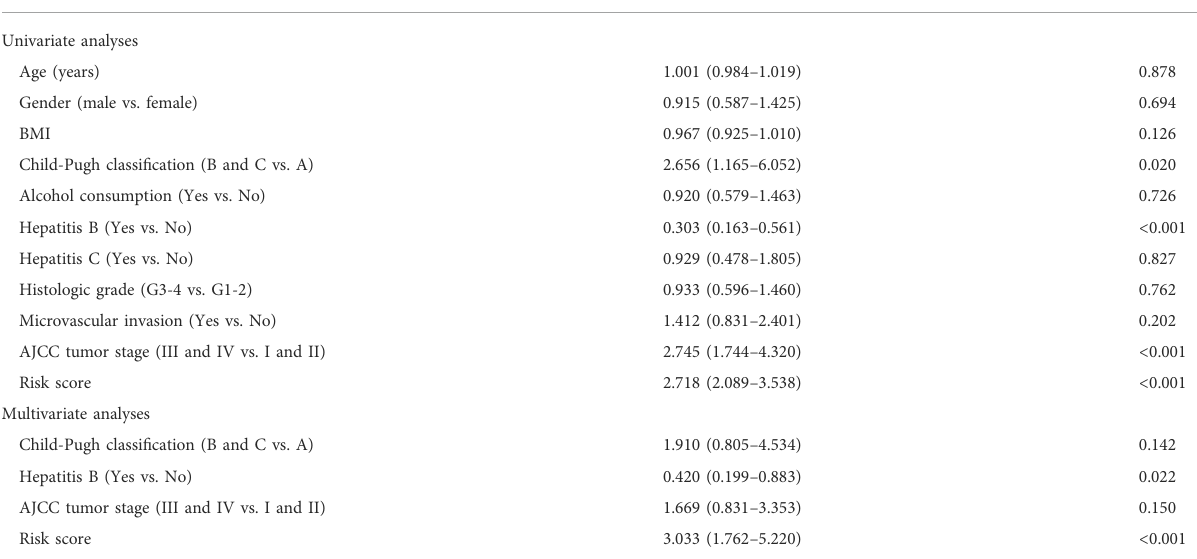
TABLE 4 Univariate and multivariate analyses of risk factors in the training cohort.